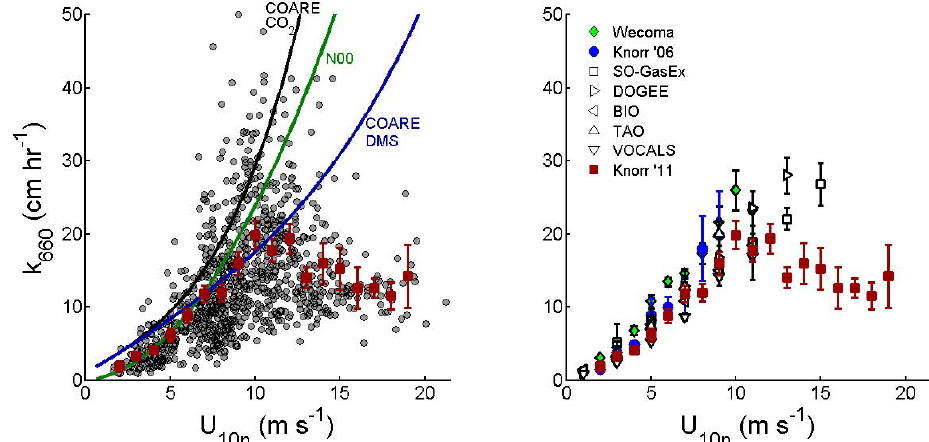
Fig. 3. Left panel: 10 min average DMS gas transfer coefficients vs. mean horizontal wind speed during the Knorr_11 cruise, expressed as k 660 and U 10 n (see Methods). Mean k 660 values were calculated for 1ms − 1 U 10 n bins (closed squares, error bars represent ± 2 std. error; minimum data points per interval = 6). For reference we plot the NOAA COARE model output using the turbulent/molecular coefficient, A = 1 . 6, and the bubble-mediated coefficient, B = 1 . 8, for CO 2 and DMS (using average Knorr_11 input parameters) and the Nightingale et al. (2000) parameterization (N00). Right panel: bin average gas transfer coefficients from this study (Knorr_11) compared with previously published DMS eddy covariance measurements: Wecoma (Marandino et al., 2007), Knorr_06 (Marandino et al., 2008), SO-GasEx (Yang et al., 2011), DOGEE (Huebert et al., 2010), BIO (Blomquist et al., 2006), TAO (Huebert et al., 2004) and VOCALS (Yang et al., 2011).